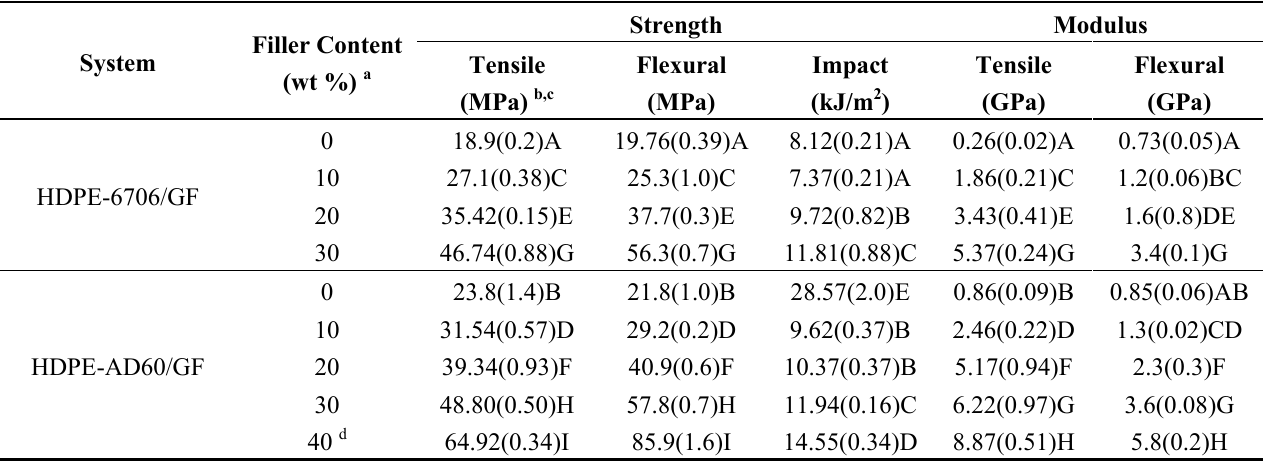
Table 1. Summary of mechanical properties of neat high density polyethylene (HDPE) and filled HDPE composites by individual glass fiber.